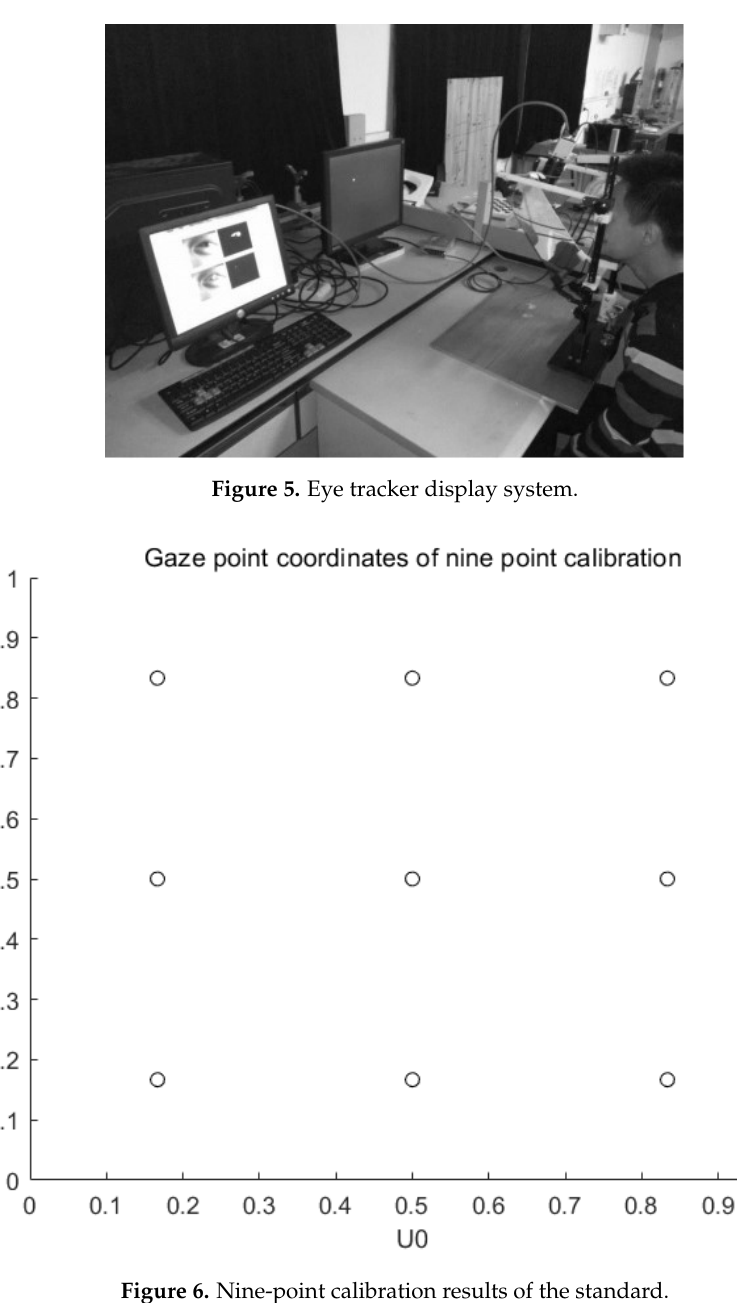
Figure 6. Nine-point calibration results of the